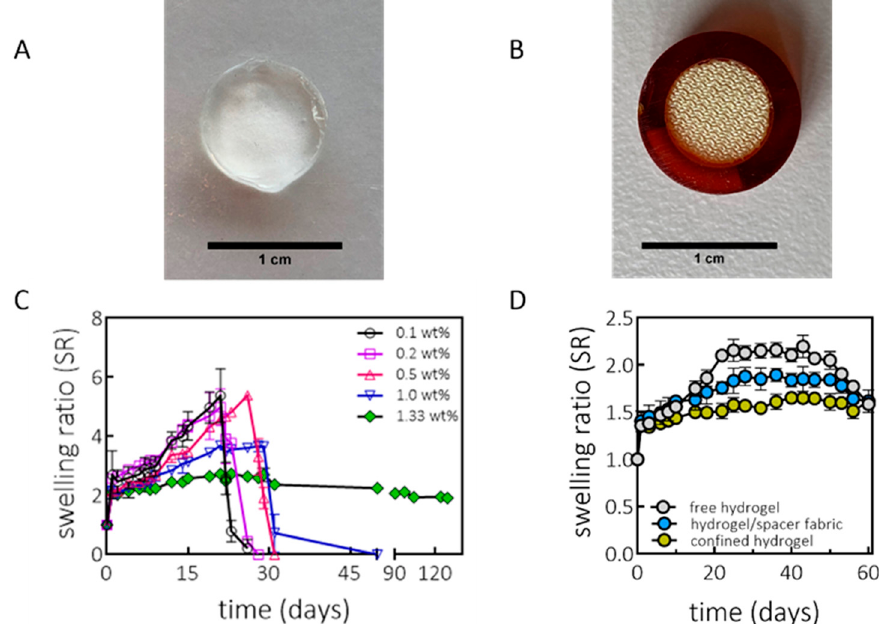
Figure 3. ( A ) CSMA/HAMA hydrogel disk after photopolymerization (10 wt% polymers, CSMA to HAMA ratio 6.5). ( B ) CSMA/HAMA hydrogel incorporated into spacer fabric and a cassette (confined hydrogel, 10 wt% polymers, CSMA to HAMA ratio 6.5). ( C ) Swelling ratio and stability in time of the CSMA/HAMA gels with different concentrations of the HAMA component (total polymer concentration was kept at 10 wt%). ( D ) Swelling profile of CSMA/HAMA hydrogels: a comparison between the free ‐ swelling hydrogel, spacer fabric ‐ filled hydrogel (semiconfined), and confined hydrogel (hydrogels were prepared with a 10 wt% polymer concentration, CSMA to HAMA ratio 6.5). All samples were measured in triplicate. Data are presented as the mean ± SD.